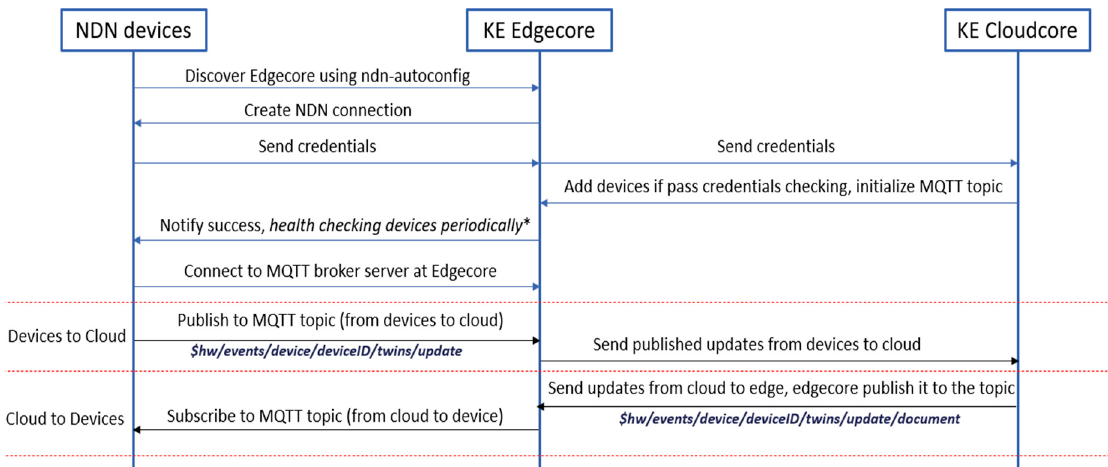
Figure 11. KubeEdge extension to support NDN device management.